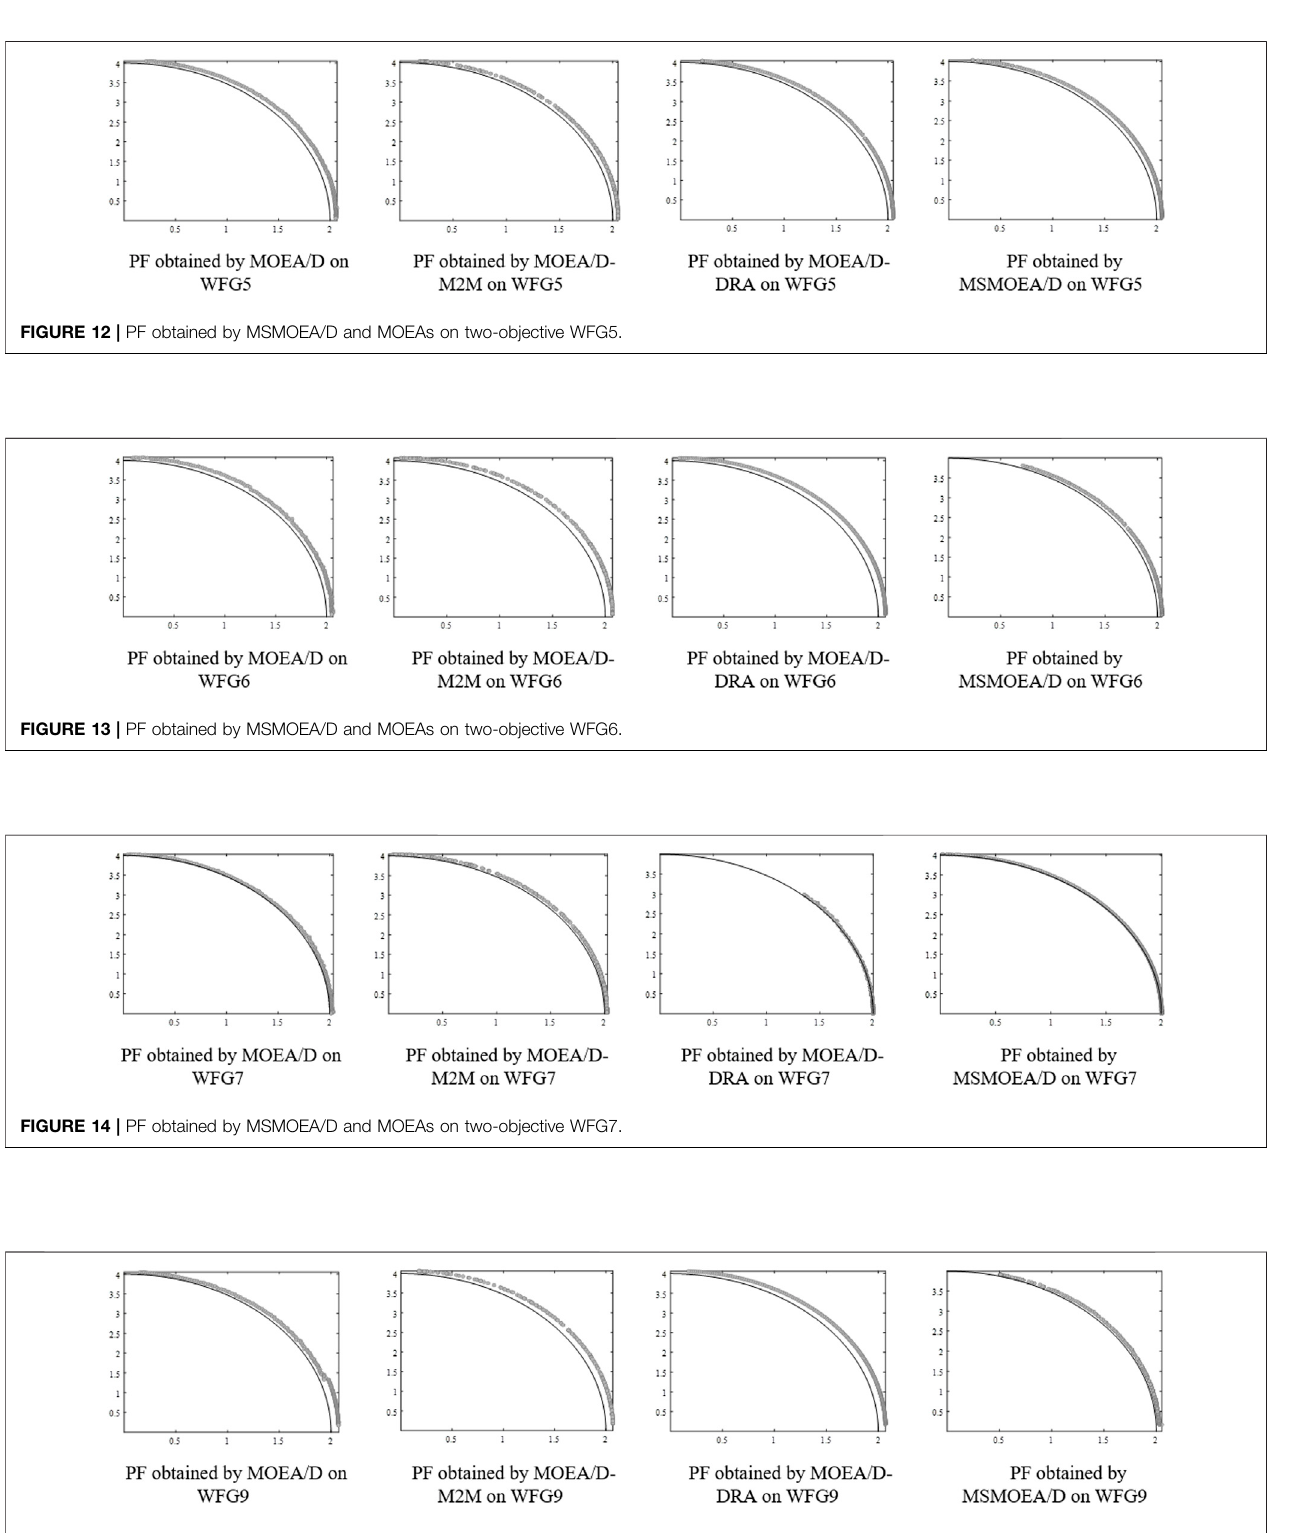
FIGURE 15 | PF obtained by MSMOEA/D and MOEAs on two-objective WFG9.